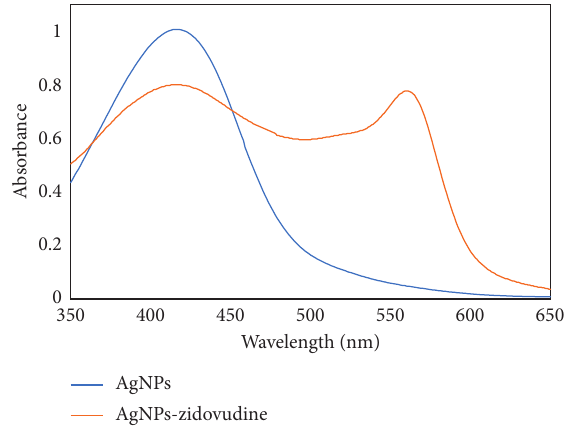
Figure 4: UV-Vis spectra of AgNPs in the absence and presence of